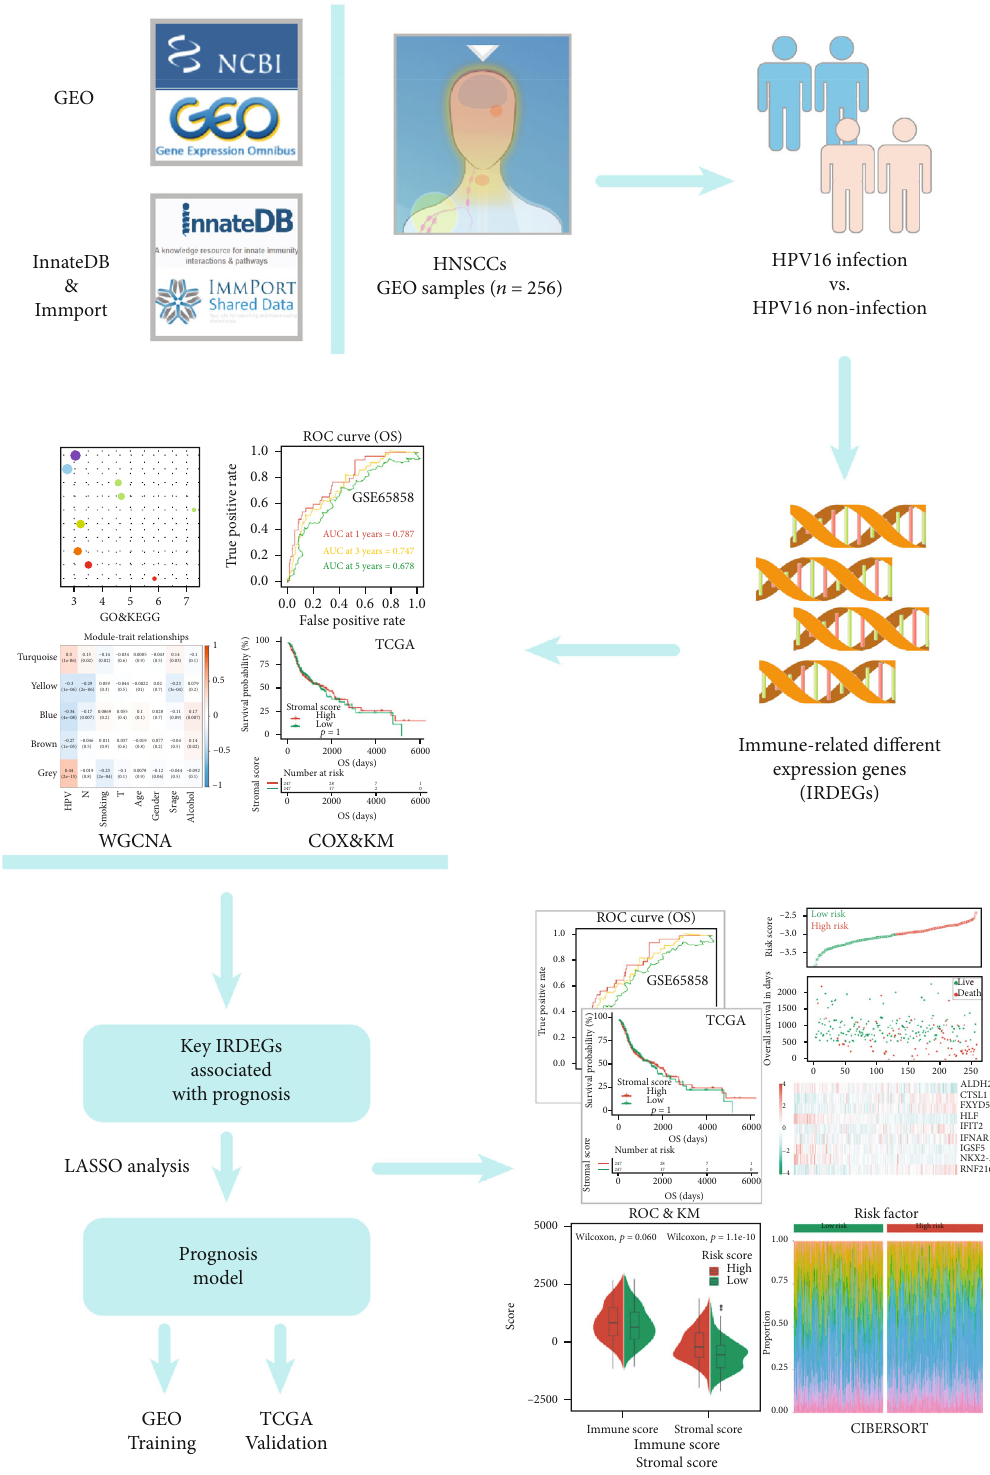
Figure 1: Flowchart of the present